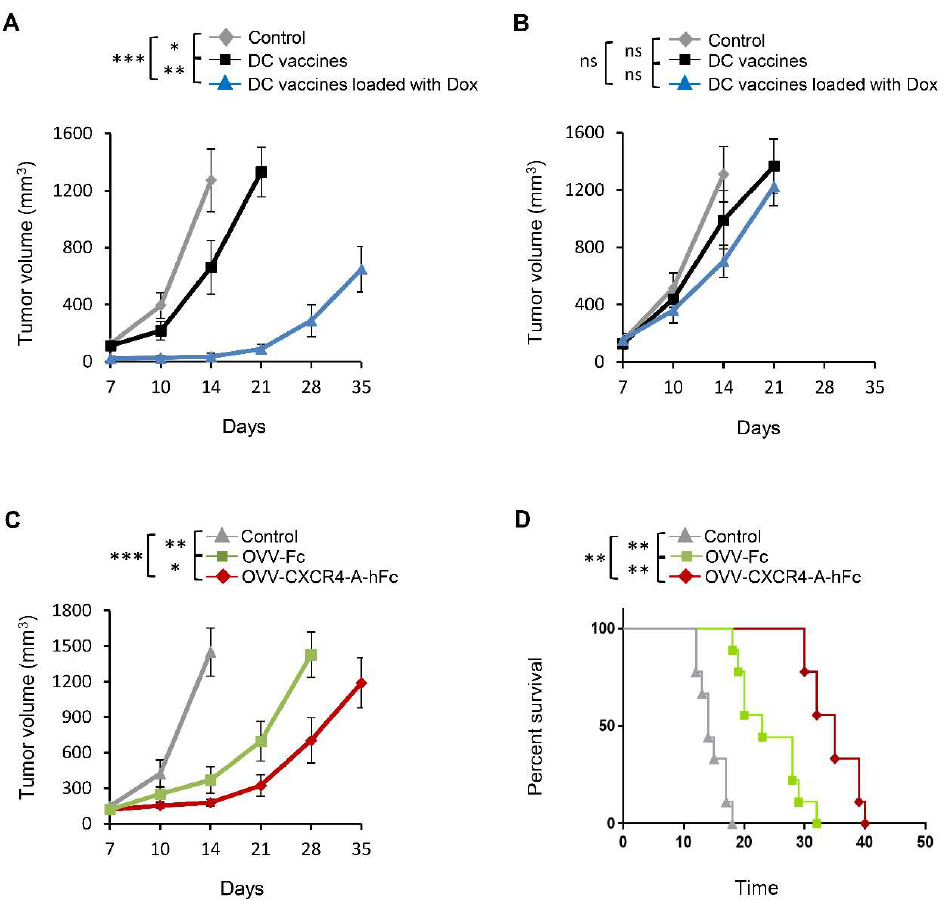
Figure 2 . Effect of DC vaccines and oncolytic vaccinia virus (OVV) treatment on tumor growth in A/J mice. ( A ) The immunogenicity of the tumor lysate-pulsed DCs as vaccines in a prophylactic setting. The BM-derived DCs were loaded with Dox-treated NXS2 tumor cell lysates or untreated NXS2 tumor cells and injected intradermally (2 × 10 6 DCs/dose) into A/J mice. Next, each mouse was